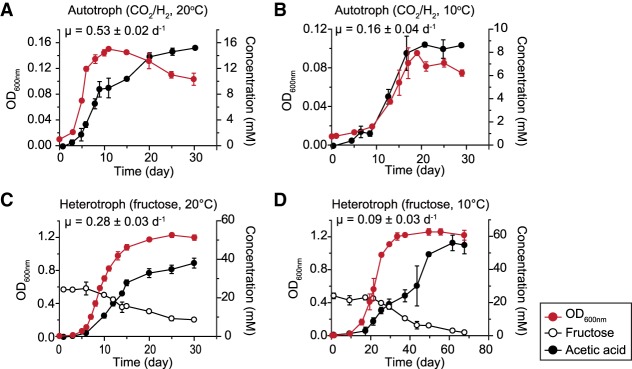
Growth and metabolite profiles of A. bakii DSM 8239. Growth curves and metabolite concentrations were measured under (A) 20°C autotrophic, (B) 10°C autotrophic, (C) 20°C heterotrophic, and (D) 10°C heterotrophic growth conditions. The data are presented as the mean of three different biological replicates ±SEM.